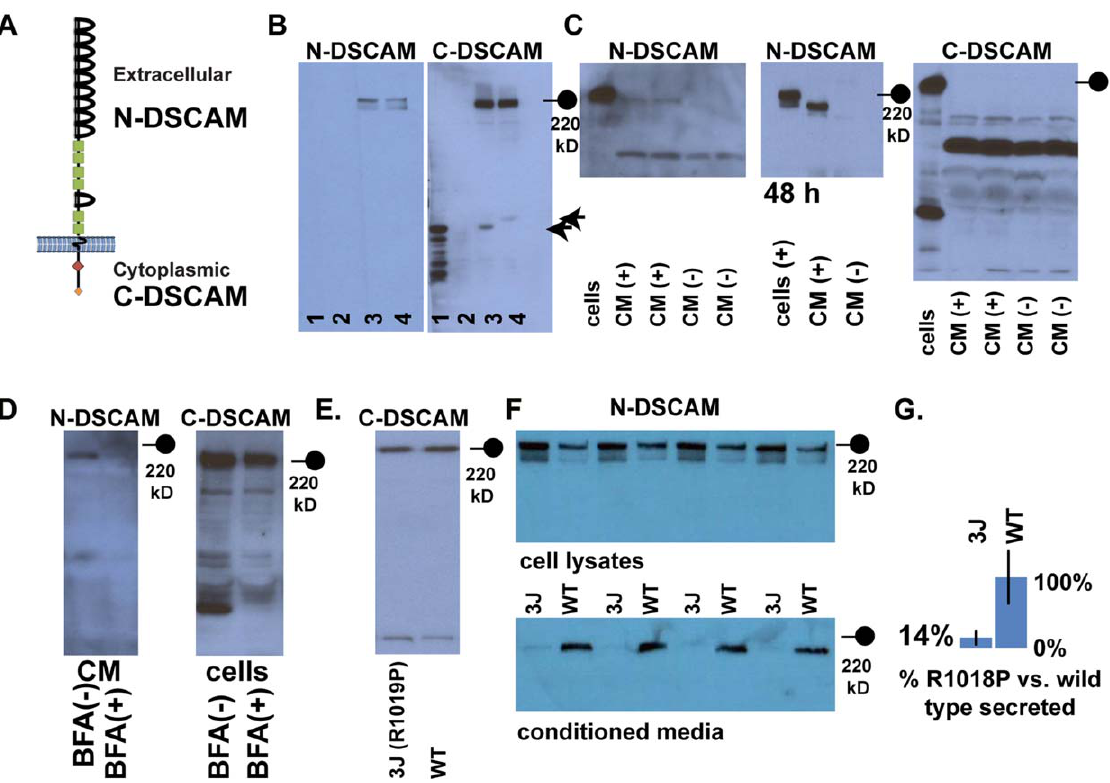
Figure 5. DSCAM is constitutively shed invitro and the R1018P mutation inhibits this secretion. A , Antibodies recognizing the extracellular N-terminus of DSCAM (N-DSCAM) or the intracellular C-terminus (C-DSCAM) were used to monitor post-translational DSCAM processing. B , Lane 1; transfected with C-terminus of Dscam , lane 2; untransfected cells, lane 3; transfected with Dscam and lane 4; transfected with myc/his tagged Dscam . The N-terminal DSCAM antibody recognizes a band of approximately 220 kD and a band slightly smaller than 220 kD in lysates of DSCAM-transfected cells. The C-terminal DSCAM antibody recognized a band of approximately 220 kD and a band the same size of the DSCAM C- terminus, at about 45 kD (arrows). C , A band the same size as the smaller of the two bands recognized by the N-terminal DSCAM antibody was detected, and increases in abundance post-transfection, in conditioned media (CM) collected from cells transfected with Dscam , but not in CM from untransfected cells. This band is not detected by the C-terminal DSCAM antibody. D , Production of shed product is dependent on membrane trafficking, as addition of brefeldin A (BFA) inhibits production of shed product. Incubation of cells in brefeldin A (BFA) also inhibits production of the 45 kD band detected by the C-terminal antibody. E and F , Cell lysates and conditioned media from N2A or HeLa cells expressing either DSCAM or DSCAM R1018P were analyzed. Wild type DSCAM protein was less abundant in cell lysates compared to DSCAM R1018P . A large decrease in the amount of shed DSCAM R1018P was observed compared to shed wild type DSCAM. G , The amount of shed DSCAM or DSCAM R1018P was normalized to the amount of protein observed in cell lysates. H , Models of DSCAM cleavage and secretion. DSCAM R1018P is cleaved into two products but is not abundantly shed. This indicates that cleavage is not necessarily directly linked to secretion. This could be because cleavage occurs directly at the membrane and is linked to secretion and occurs separately after internalization. Alternately, cleavage could occur after internalization of DSCAM, the N-terminal portion of which is then secreted, and DSCAM R1018P could be deficient in this subsequent